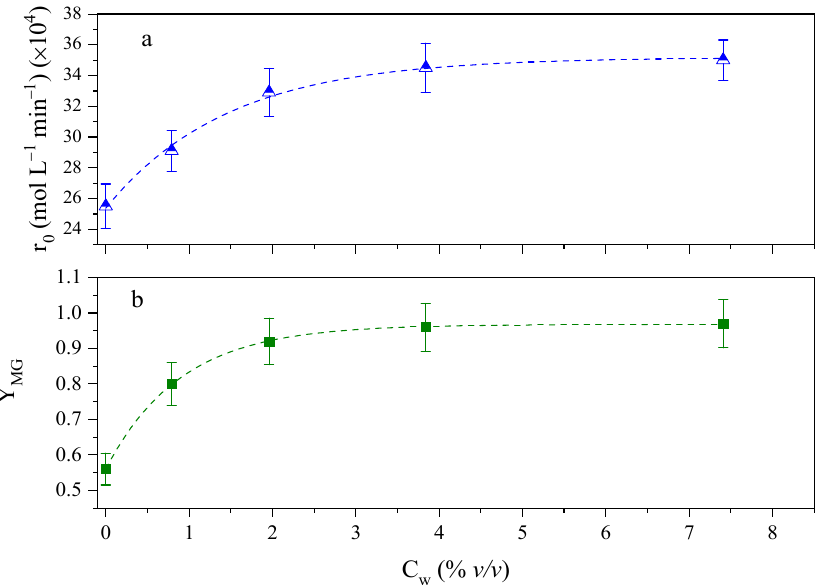
Figure 4. Effects of the addition of water on the triphasic reaction system and the esterification of ibuprofen with glycerol at T = 80 ◦ C, C I0 = 100 g · L − 1 , N = 720 rpm and Gly/Tol 20/5 over initial reaction rate ( a ) and monoglyceride yield ( b ).